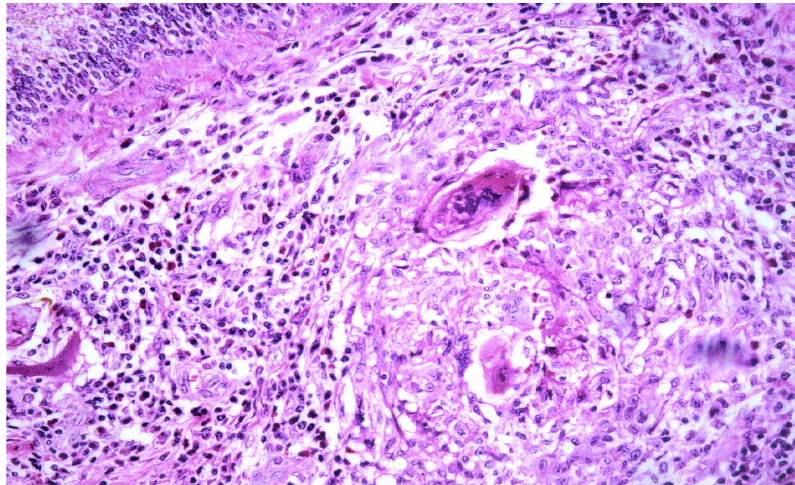
Figure 1 – Photomicrography of epididymis slide showing granulomatous chronic inflammation with Langhans-type giant cell reac- tion, presenting a large number of eosinophils around spiculated structures similar to Schistosoma mansoni eggs (HE,